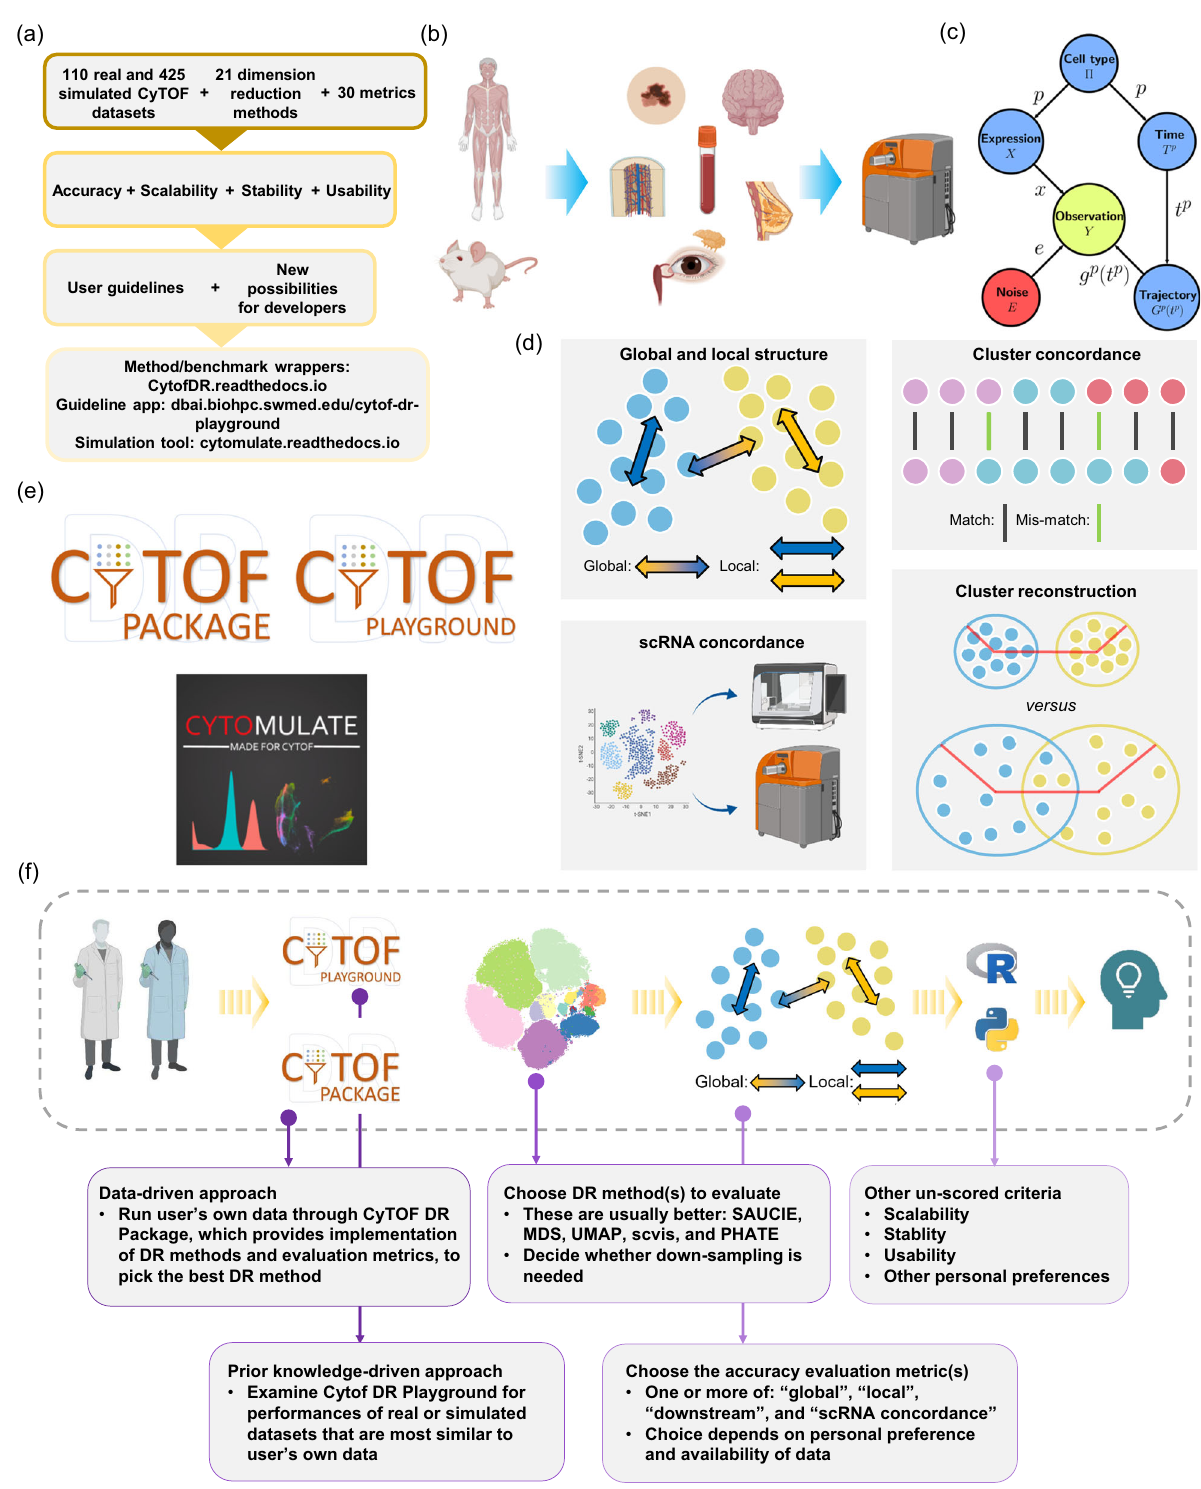
Fig.1|Overviewofseveralkeyaspectsofthisbenchmarkstudy.a Thedatasets, DRmethods,validationmetrics,anddeliverablesofthisstudy. b Synopsisofthereal CyTOF datasets used for evaluation in this study. Elements in this panel were cre- ated with BioRender.com. c The simulation algorithm for CyTOF data. d Diagrams explaining several of the most important validation metrics in the accuracy cate- gory.ElementsinthispanelwerecreatedwithBioRender.com. e